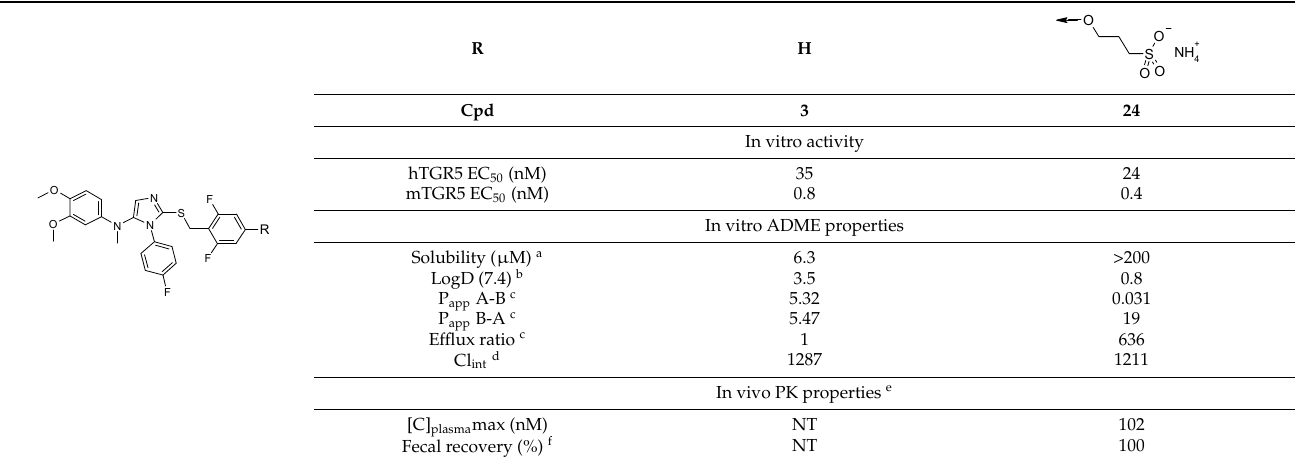
Table 1. Pharmacological and ADME/PK properties of a sulfokinetophore-coupled TGR5 agonist (cpd 24) compared to the parent agonist (cpd 3) [45].